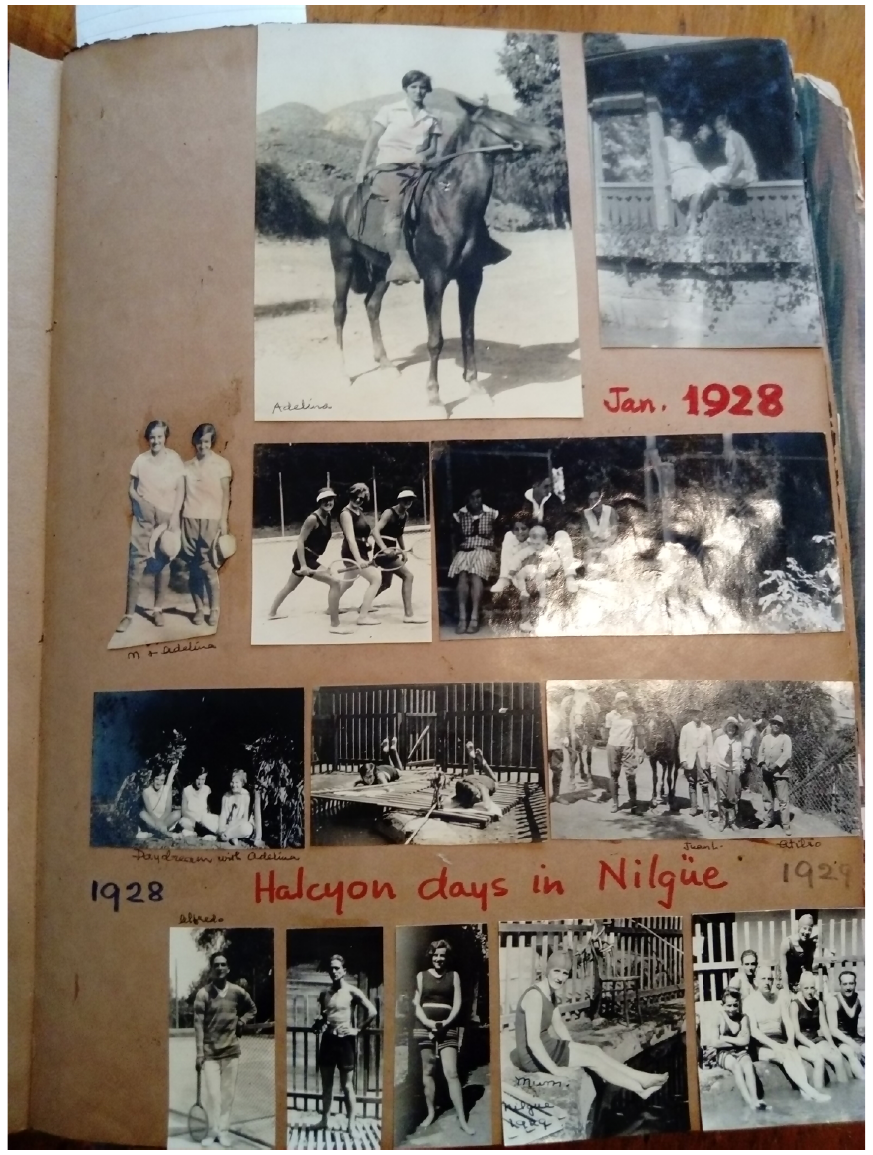
Photographs from Monica’s scrapbook showing her ‘halcyon days’ in Chile (permission courtesy of Annabel